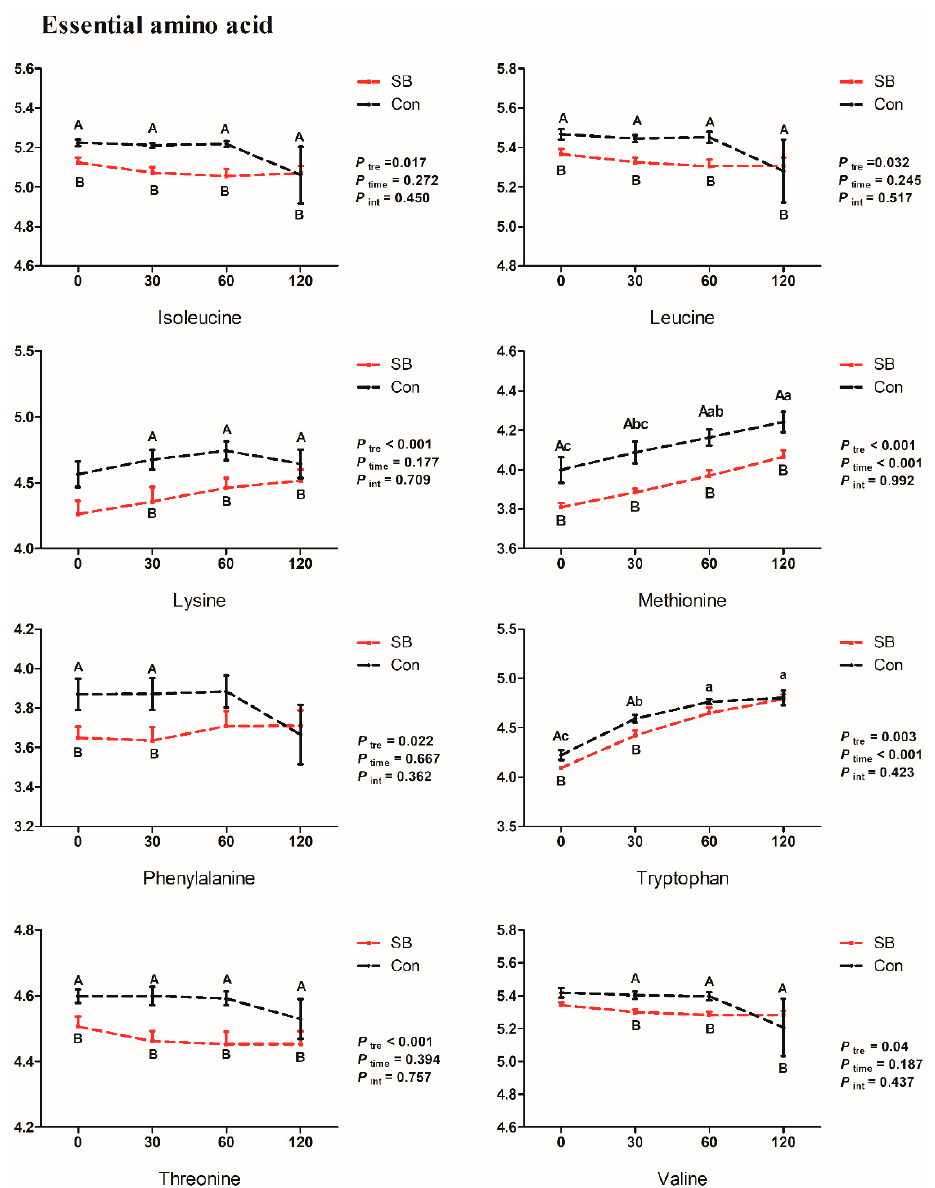
Figure 6. Dynamic changes of the relative concentrations of essential amino acids. X-axis presents the relative concentrates of corresponding metabolites with Log processing of the peak area. Di ff erences were analyzed by two-way ANOVA using PROC MIXED with time and SB treatment as the main factors followed by post-hoc analysis in SAS. Ptre, Ptime, Pint represents the significances of SB treatment, time, and interaction e ff ects, respectively. Superscript with A or B means significant di ff erence between control group (Con) and sodium butyrate group (SB). Superscript with a, b, and c means significant difference over time.